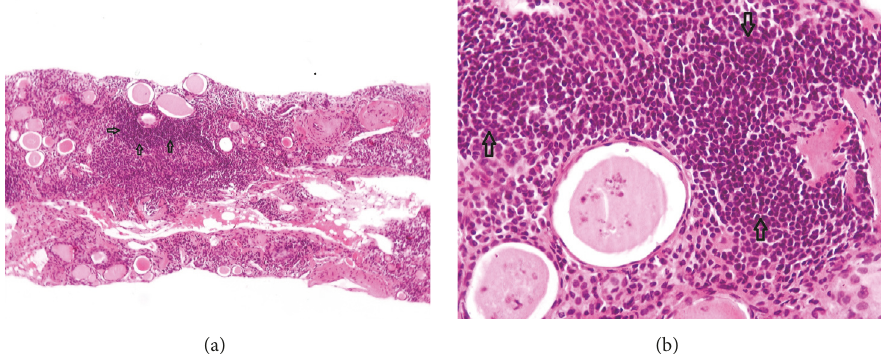
Figure 1: (a) Hematoxylin and eosin stain show typical histopathological appearance of acute interstitial lesions in light microscopy. (b) Hematoxylin and eosin stain shows diffusive interstitial infiltration of polymorphic inflammatory cells, predominantly T-cells, monocytes, and